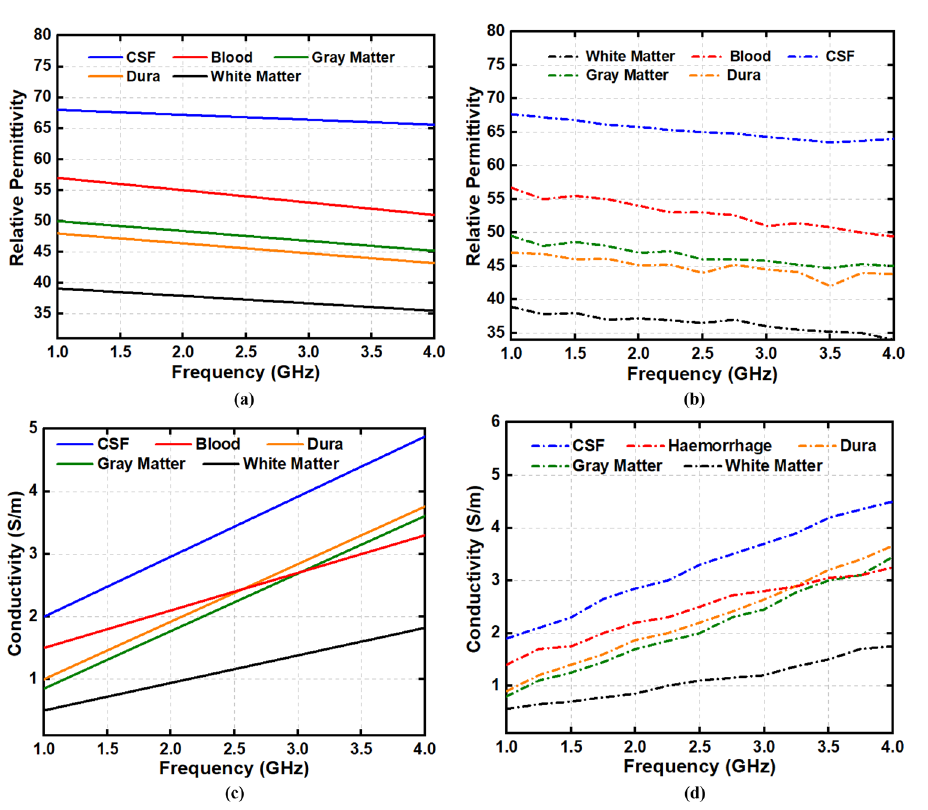
Figure 7. ( a ) Reference and ( b ) measured permittivity; ( c ) reference and ( d ) measured